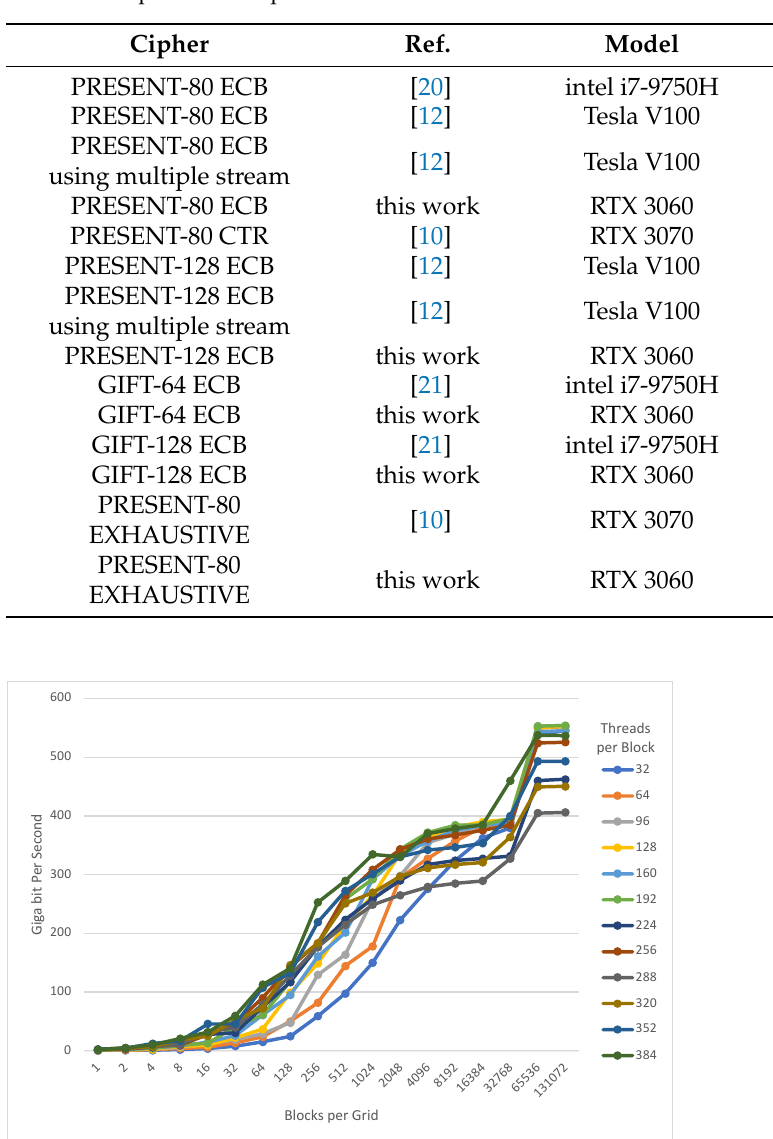
Table 3. Comparison of implementation results for CPU and GPU.